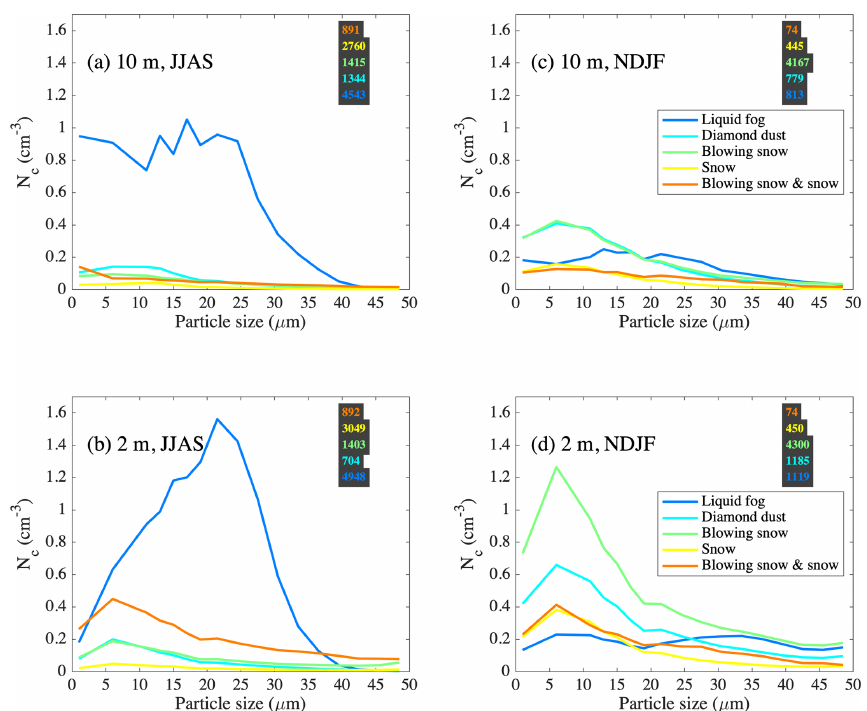
Figure 9. Average number concentration ( N c ) within the FM100 size bins for different classifications measured at 10m (top row; a , c ) and 2m (bottom row; b , d ). The left column (a, b) is for June–September (JJAS) and the right column (c, d) is for November–February (NDJF). The bin centers for the sizes are 1, 6, 11, 13, 15, 17, 19, 21.5, 24.5, 27.5, 30.5, 33.5, 36.5, 39.5, 42.5, 45.5, and 48.5µm (refer also to the Supplement for additional information on FM100 sizing). Because the FM100 bin sizes are variable, the bin counts have been normalized such that the integral of the curves equals average concentration for all bins. The values over the grey background are the number of 1min samples in each distribution.